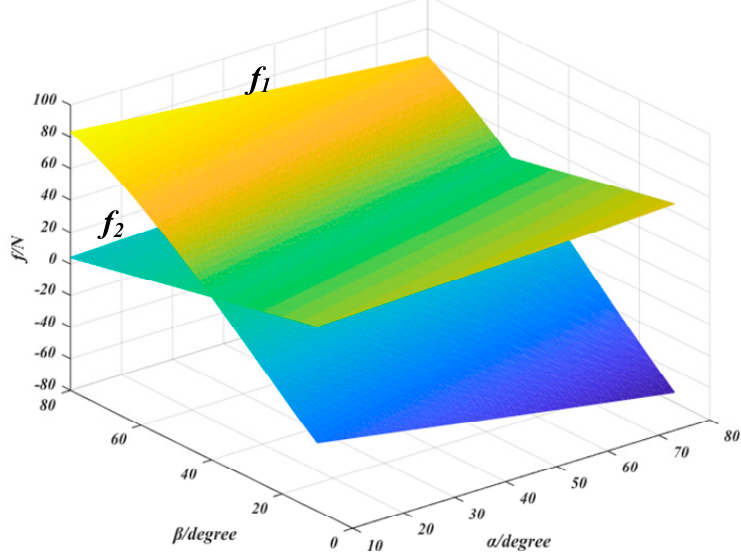
Figure 16. Grasping force under the COSA mode.